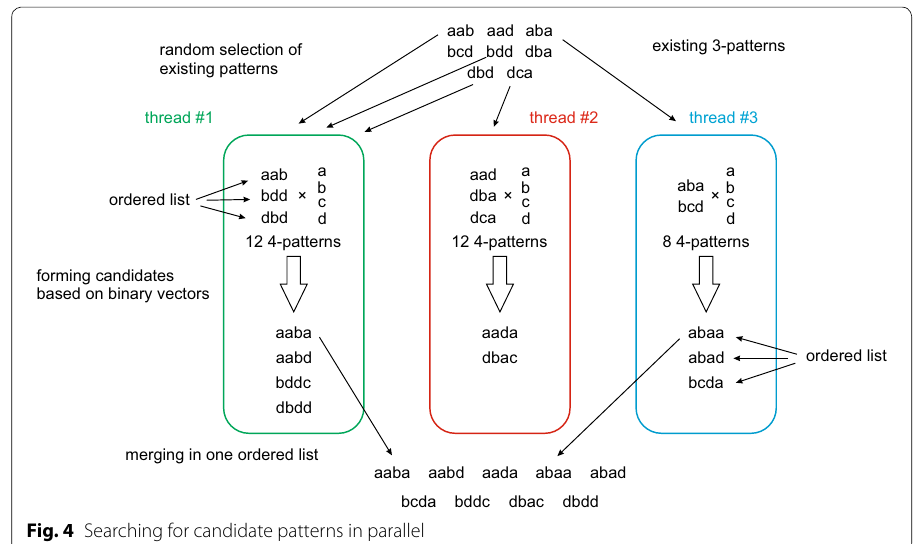
Fig. 4 Searching for candidate patterns in